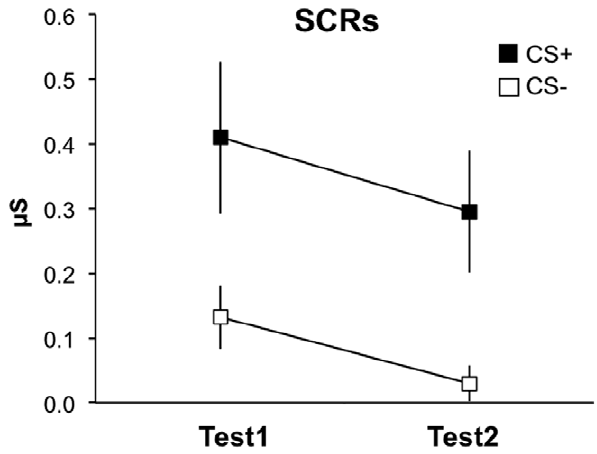
Figure 1. Instructed fear (study 1): Skin conductance. SCRs show stable threat responding across the two test runs (IF-Test1, IF-Test2). Error bars: s.e.m.